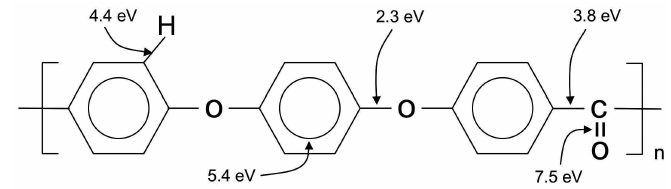
Figure 4. Bond energies of a PEEK molecule